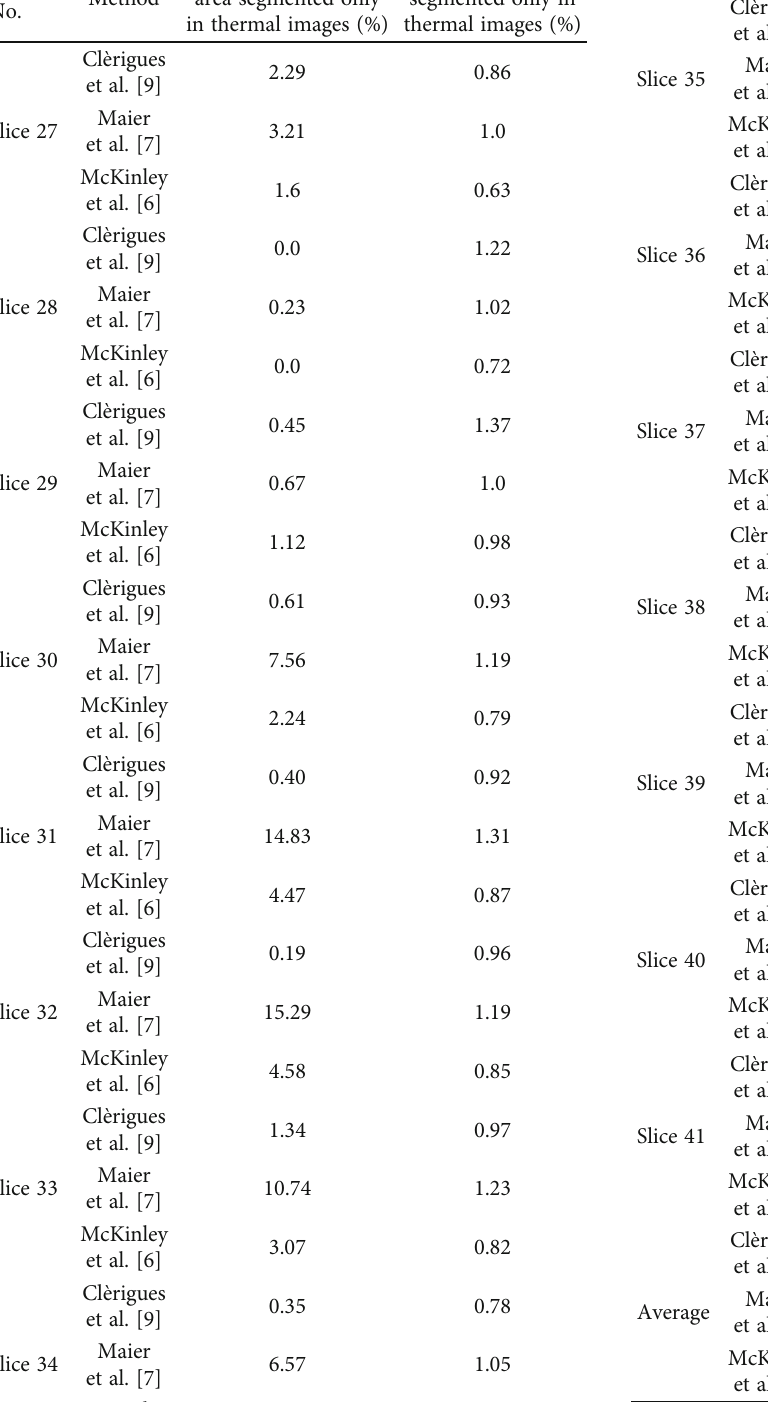
dataset; the fi gure contains the ground truth of penumbra merged with infarct core, the thermal images in color, and grayscale thermal images. For training and testing U-Net